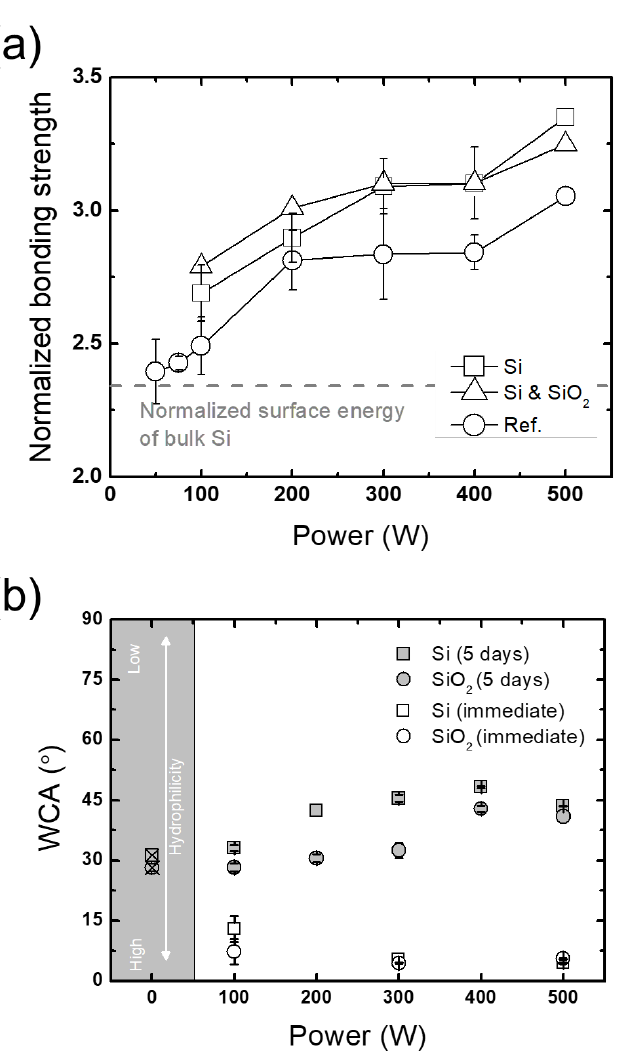
Figure 10. ( a ) Comparison of bonding strengths obtained from wafers stored between plasma treatment and DIW cleaning steps normalized to the bonding strength with no plasma treatment and ( b ) Comparison of water contact angles (WCAs) obtained from plasma treatments at different RF powers.